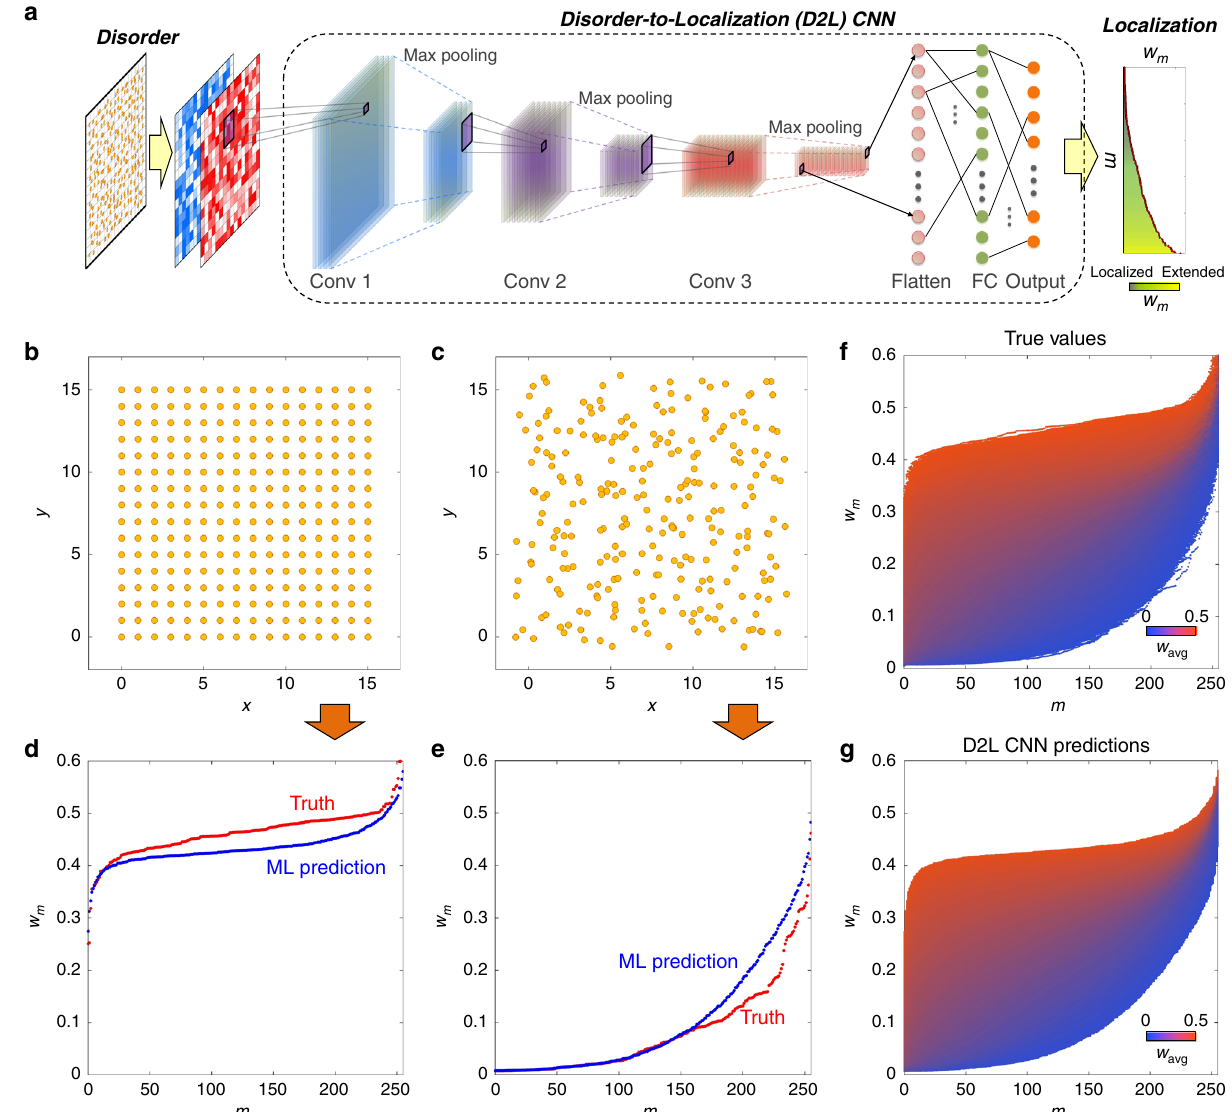
Fig. 2 Disorder-to-localization convolutional neural network for predicting localization. a The network structure of the disorder-to-localization (D2L) convolutional neural network (CNN). The details of the network parameters are shown in the “ Methods ” section. b – e The prediction of localization properties w m for b , d weakly disordered, and c , e strongly disordered structures. f , g Comparison of localizations between f the ground truth and g the D2L CNN prediction for a broad range of average mode area w avg of the test data set (1 × 10 4 realizations). The period of the 16 × 16 unperturbed square lattice (256 atoms) is set to 1 and the hopping parameters are t 0 = 3.14 × 10 − 2 and α = 1.1454 throughout the manuscript. Although the on-site energy does not affect mode areas, we set the on-site energy as ε = 1 for energy spectra in the later discussion (Supplementary Note 6). Mode numbers m are sorted according to localization values in all examples throughout the